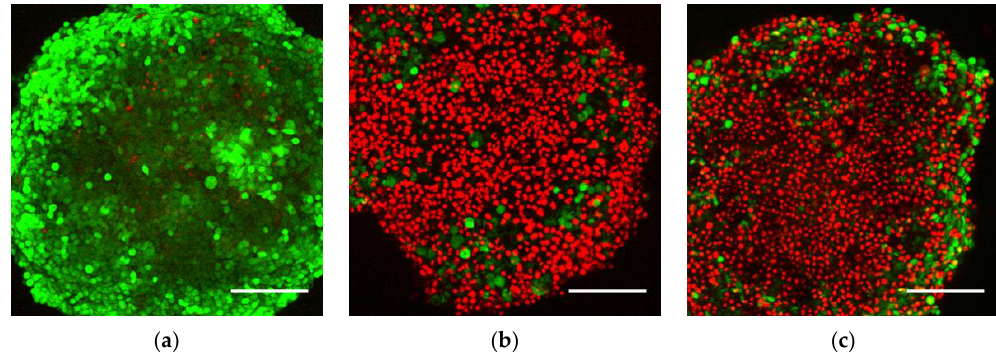
Figure 4. Representative confocal images of HepG2 spheroids exposed for 24 h to ( a ) culture medium, ( b ) Ag-NPs and ( c ) ZnO-NPs. Spheroids were exposed to 30 µg/cm 2 (85 µg/mL) of Ag- and ZnO-NPs for 24 h, before staining. Dead cells were stained with propidium iodide (PI) ( red ) and viable cells with fluorescein diacetate (FDA) ( green ). The images are z-stack projections from the spheroid surface and approximately 150 µm down toward the core. An increase in number of dead cells on the surface of the spheroids was seen after exposure to Ag-NPs and ZnO-NPs. Scale bar = 200 µm. Representative images from two independent experiments ( n = 2), each with at least three parallel spheroids.